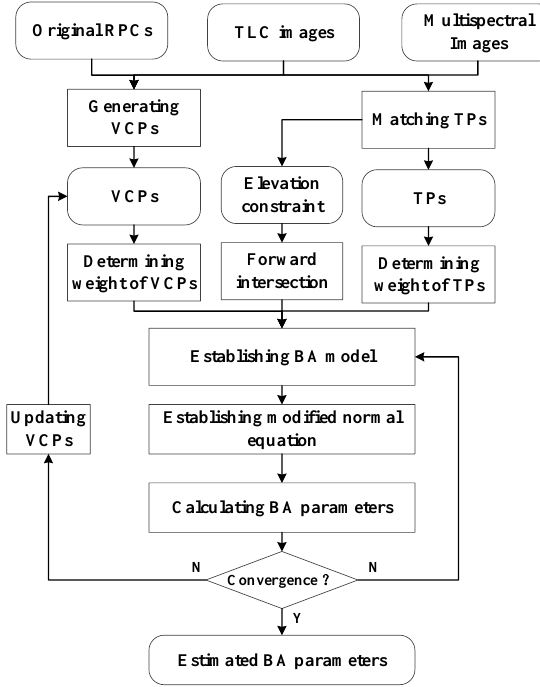
Figure 1. Approach of the BA without use of